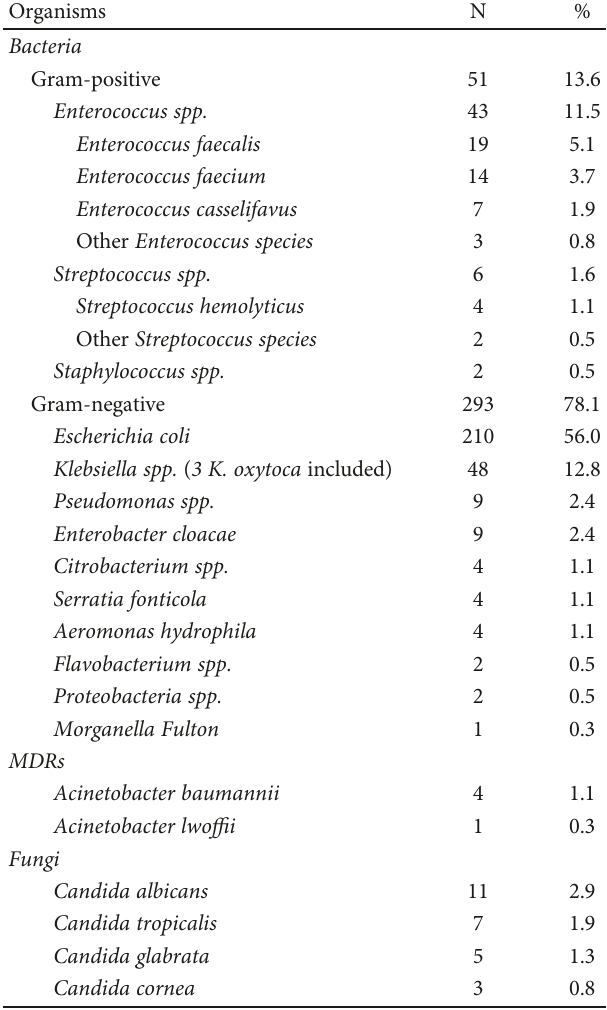
Table 1: Baseline demographics and endoscopic features of enrolled patients.